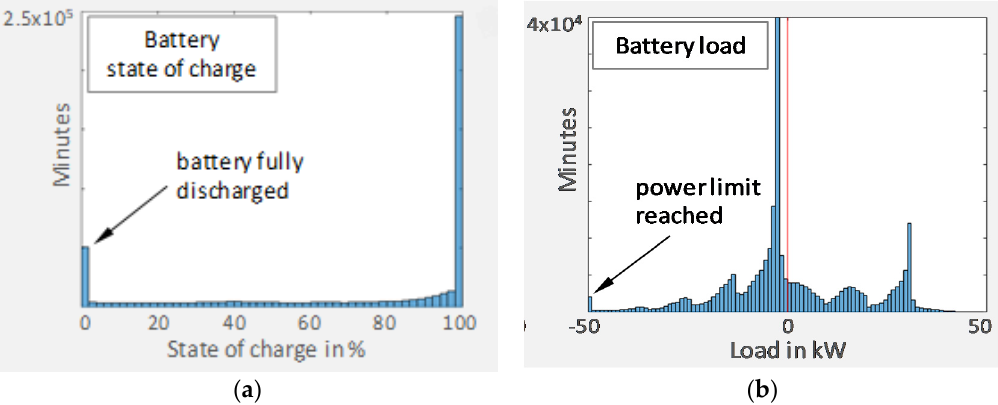
Figure 5. Time allocation of the state of charge ( a ) and battery power ( b ) in the simulation year. Battery capacity and battery power reach their limits.